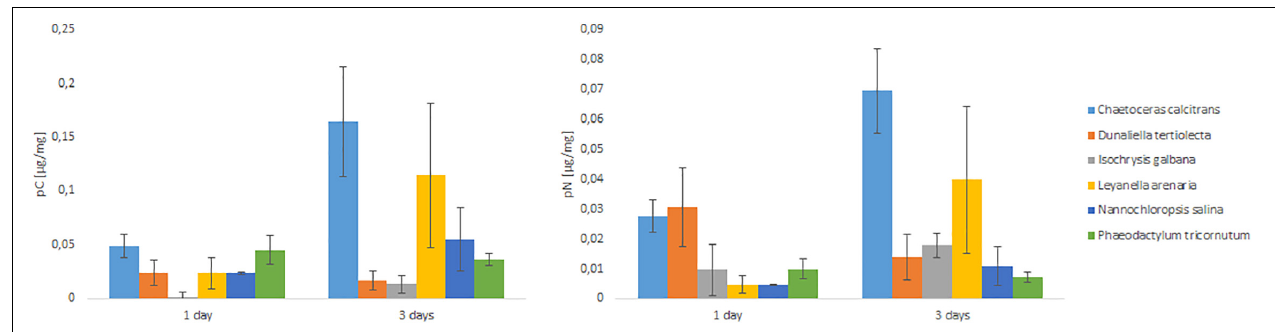
FIGURE 2 | C and N uptake of different food sources (fresh algae) by C. selseyense . The datapoints are calculated from n = 3 replicates and the error bars indicate the standard deviation.